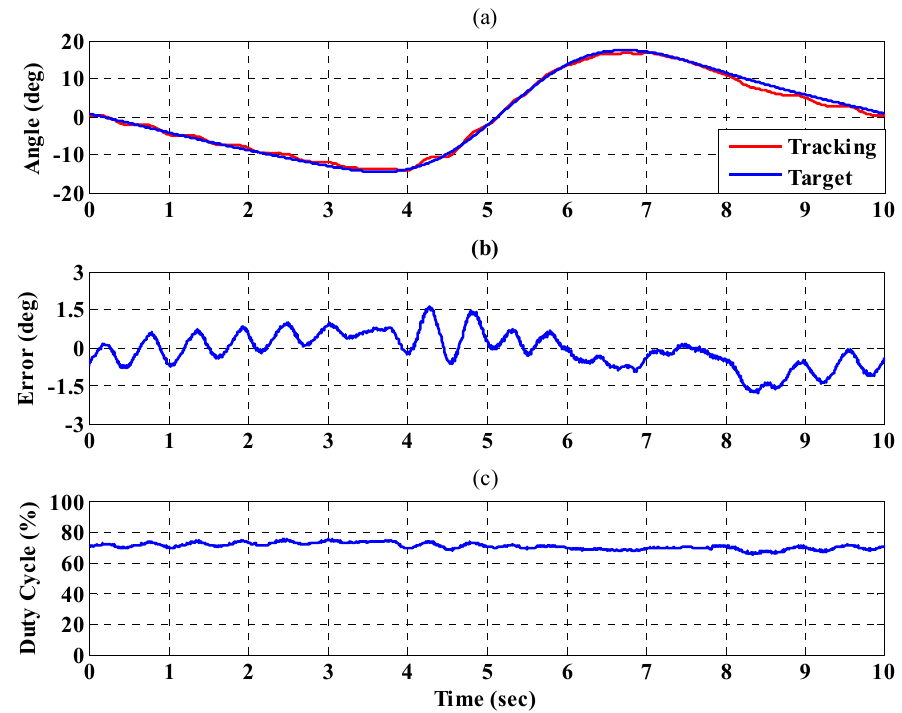
Figure 18. Tracking response of the interval type-2 fuzzy sliding pulse-width modulation controller on the left hip for the PGOS. ( a ) output response; ( b ) tracking error; ( c ) pulse-width modulation control signal.